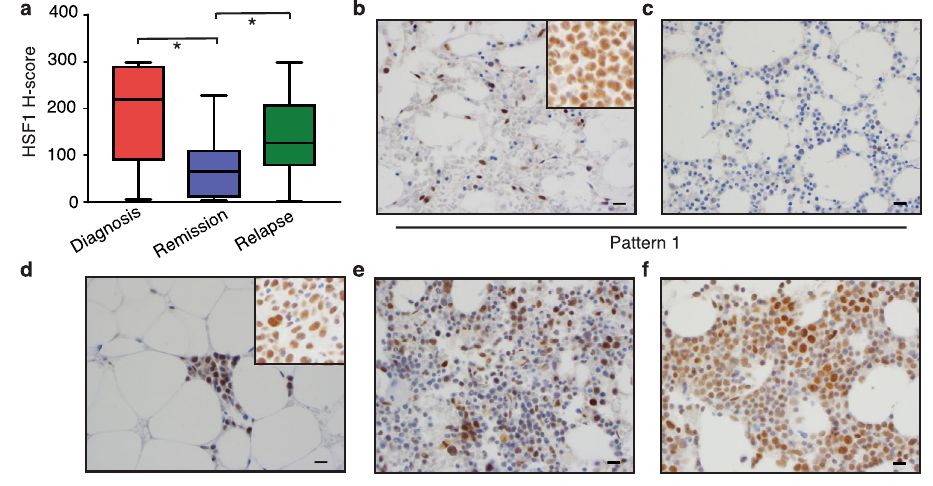
Fig. 8 | Expression of HSF1 might serve as a marker to monitor AML status. a HSF1 H-score index in AML samples at diagnosis, remission, or relapse ( n =39 primary AML samples). Box plots show median and fi rst/third quartiles. ANOVA with LSD post-hoc analysis was used, * p =0.0001. b – f Representative pictures showing 2 different HSF1 staining patterns in AML patients. b – c Pattern 1,